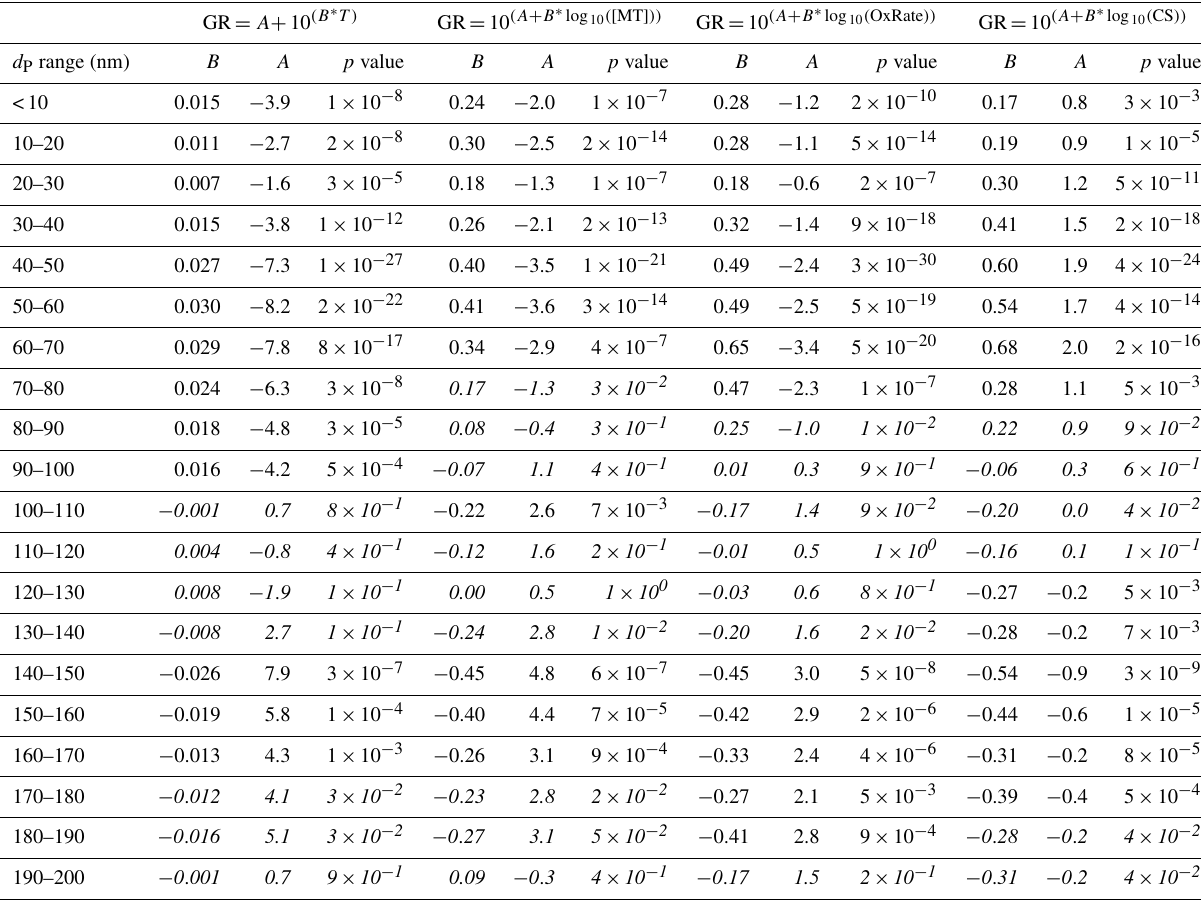
Table A1. Fitting parameters resulting from linear least-squares fits for parameterizations of growth rates with growth period starting sizes in 10nm bins and the related correlation coefficient p values, indicating the probability of getting a similar correlation as random chance. Fittings and correlations are for all determined growth rates (>2h) during April–September. Correlations which cannot be considered statis- tically significant ( p >0.01) are shown in